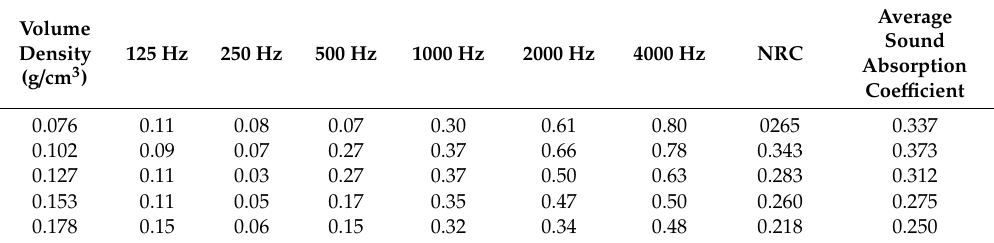
Table 2. NRC and average sound absorption coe ffi cient of composite materials prepared with di ff erent densities.